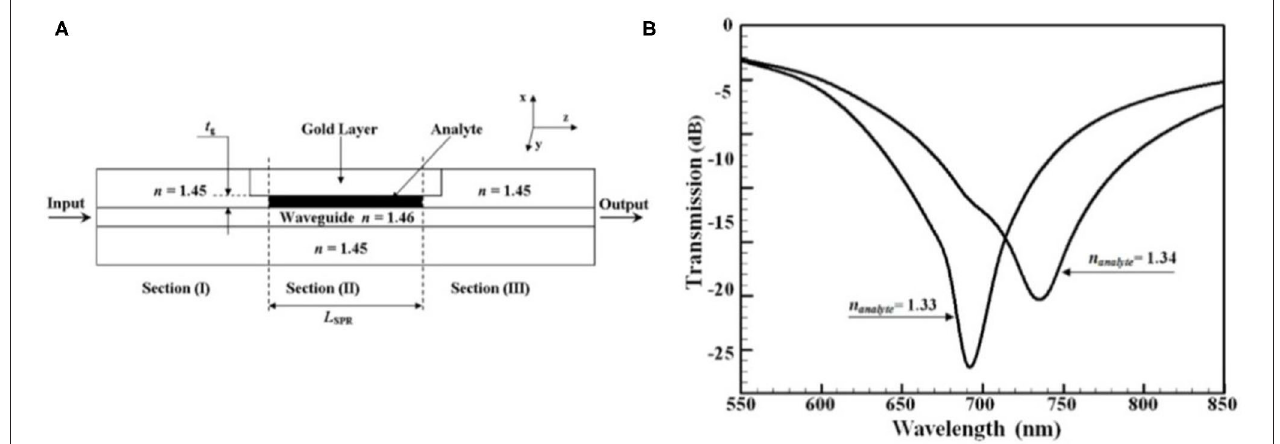
FIGURE 4 | Schematic and performance of the proposed waveguide SPP sensor [58]. (A) The cross section of the waveguide SPP sensor with input section (I), SPR section (II), and output section (III). (B) Shift in resonant wavelength with respect to n analyte in the proposed waveguide SPP biosensor with a 175 µ m length of SPR section and a 175nm thick analyte layer. Reprinted with permission from Akowuah et al. [ 58] © The Optical